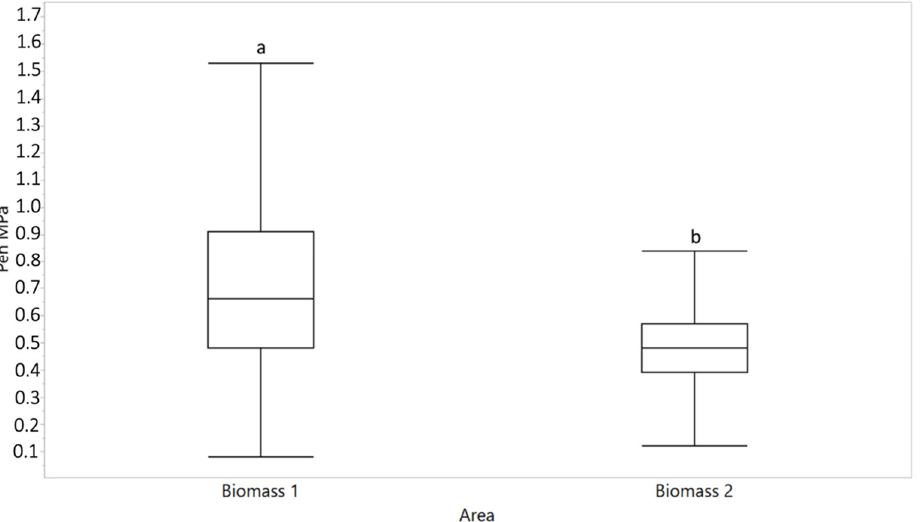
Figure 3. Penetration resistance of the two areas sown with Phalaris arundinacea . The letters indicate a